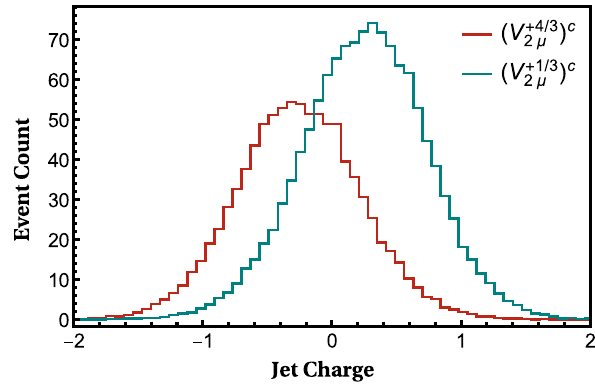
Fig. 11 Charge (in the unit of e ) reconstruction of c - and s -jets from the vector doublet leptoquark decay Table 10 Number of events after the cumulative cuts for the vector √ s = 318 . 12 GeV and L int = 100 fb − 1 doublet leptoquark V c at 2 μ